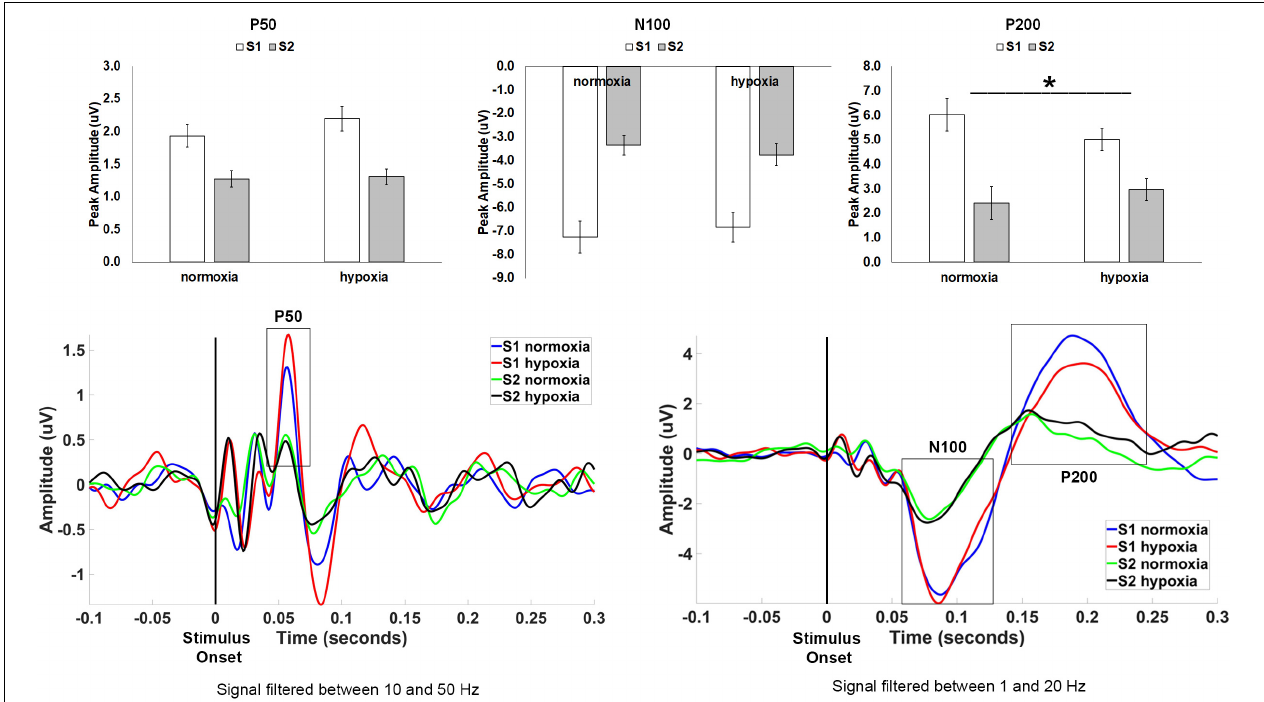
FIGURE 3 | Top row: Average peak amplitude for the auditory paradigm, shown separately for the P50, N100, and P200 components. A sensory gating effect (i.e., reduced amplitude for S2 compared to S1) emerged for all three components. Only the P200 component showed a significant effect of hypoxia, with decreased sensory gating under hypoxic compared to normoxic conditions. * p < 0.05. Error bars represent standard error of the mean. Bottom row: Grand average waveforms at electrode